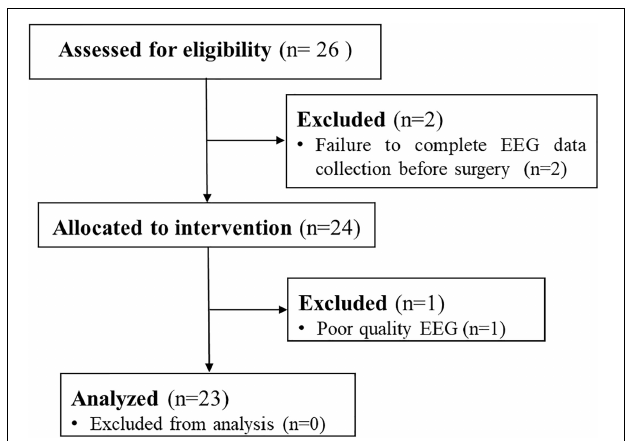
FIGURE 1 | Flow chart of patient selection and